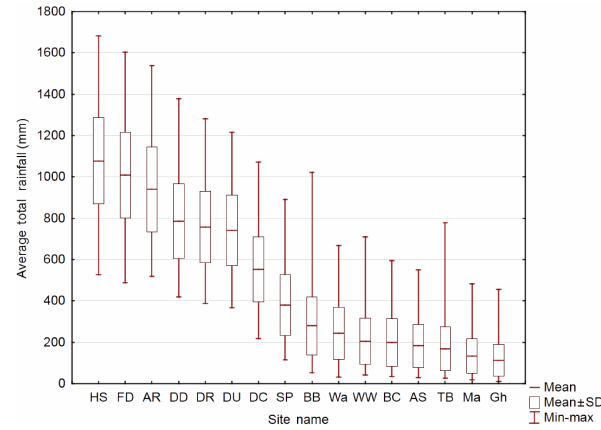
Figure 4. Mean annual wet season rainfall (mm) from 1900 to 2010 for each site along the NATT (Table 1). Boxes show 1 standard devi- ation and whiskers show maximum and minimum seasonal rainfall for each